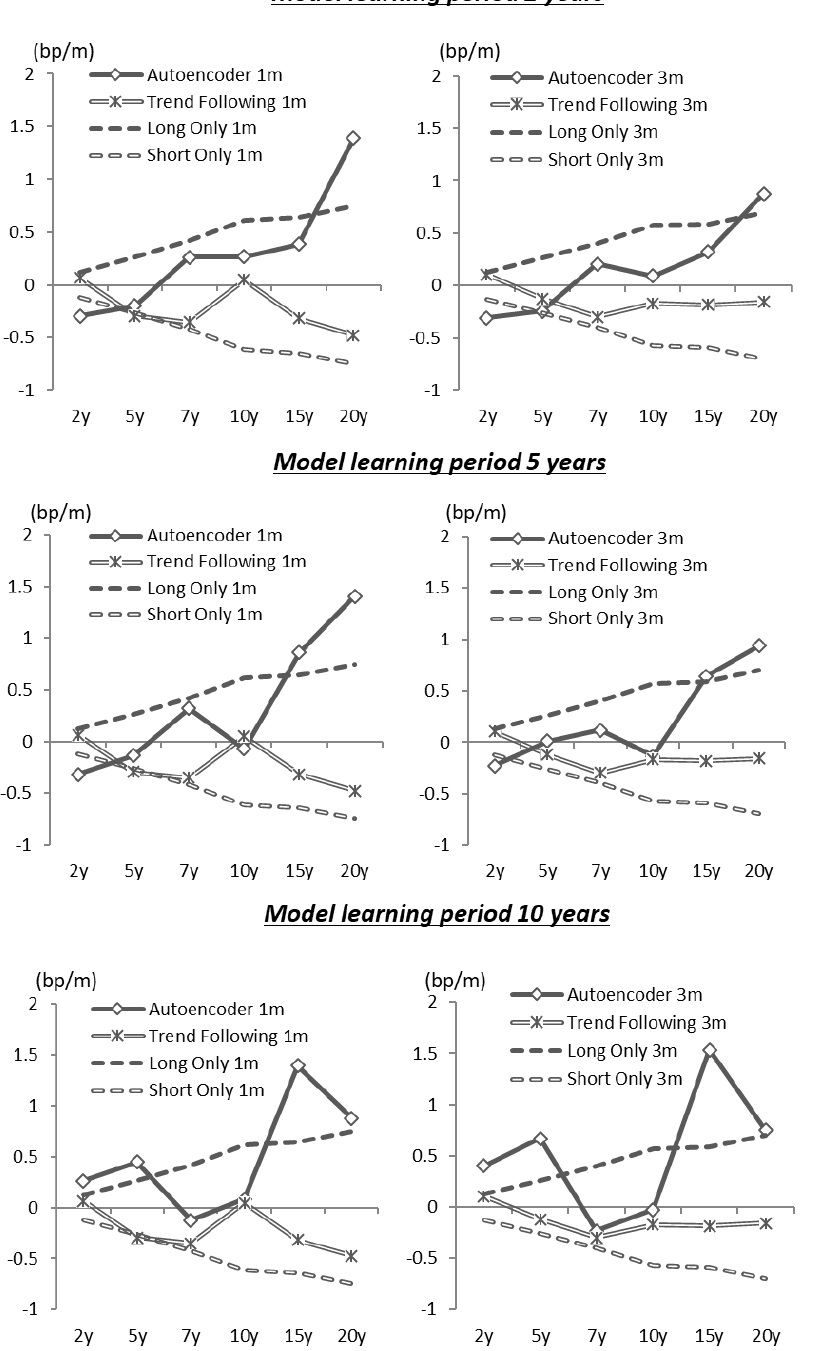
Figure A2. Average monthly capital gains with a four-node hidden layer with investment periods of 1 or 3 months.